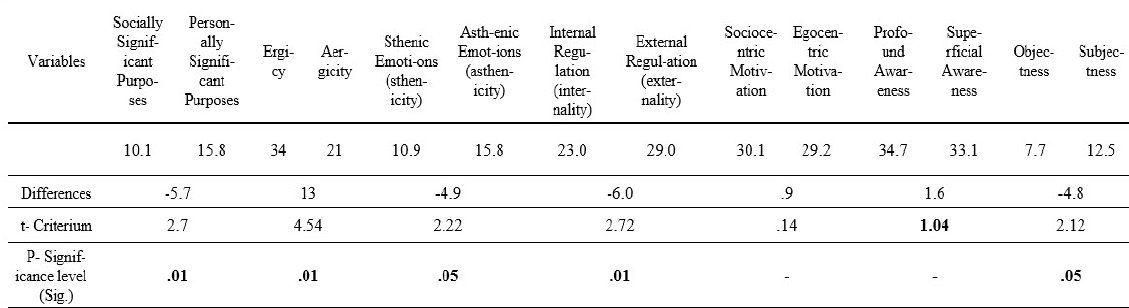
Table 2. Comparative analysis of the values of variables for respondents with an average level of persistence (n=89)